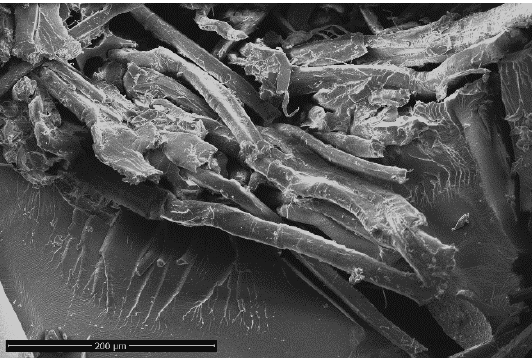
Figure 3. SEM micrograph of Flax ‐ AR laminate surface after 60 days of salt ‐ fog exposition.